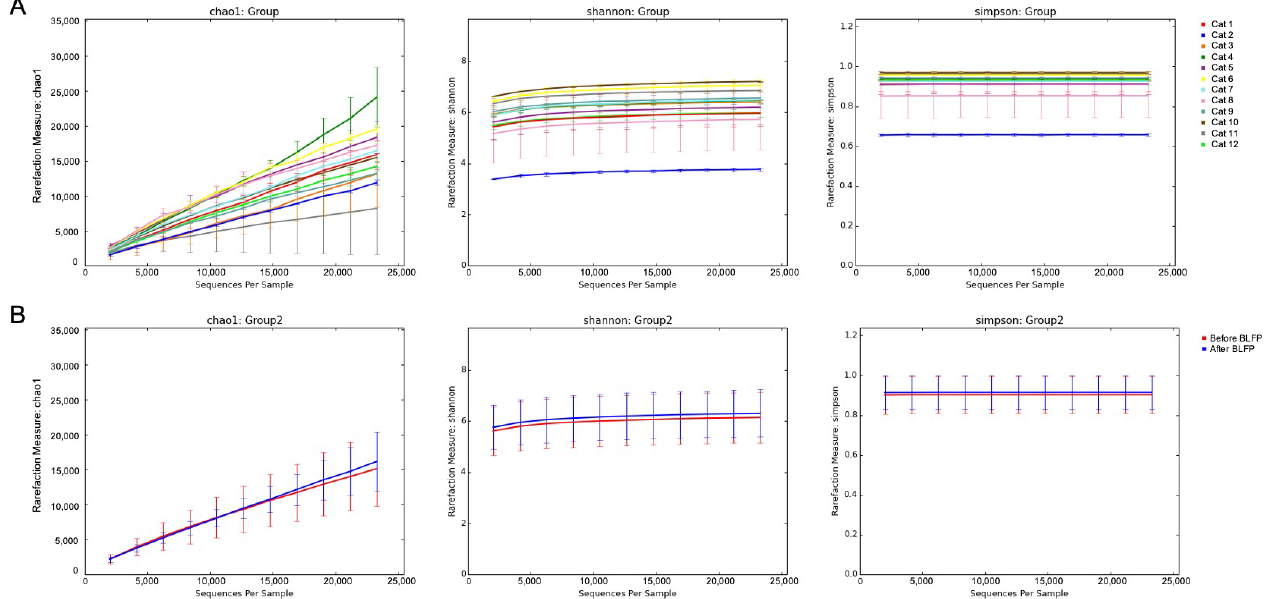
Figure 1. Alpha diversity indices, including Chao1, Shannon, and Simpson. ( A ): All of the samples. ( B ): Alpha diversity of microbial communities before (red) and after (blue) the treatment of Bacillus licheniformis -fermented products (BLFP) in the diarrheal cats.